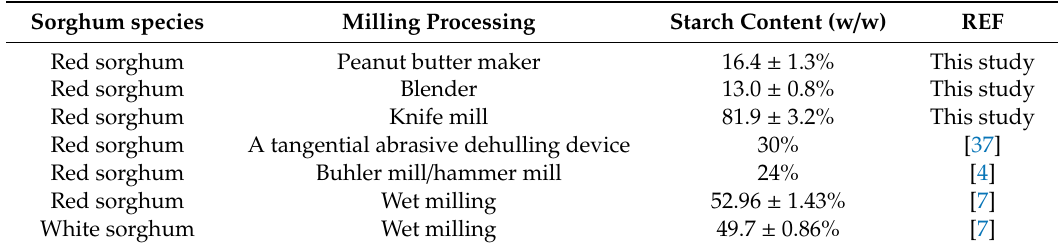
Table 3. The starch content in sorghum